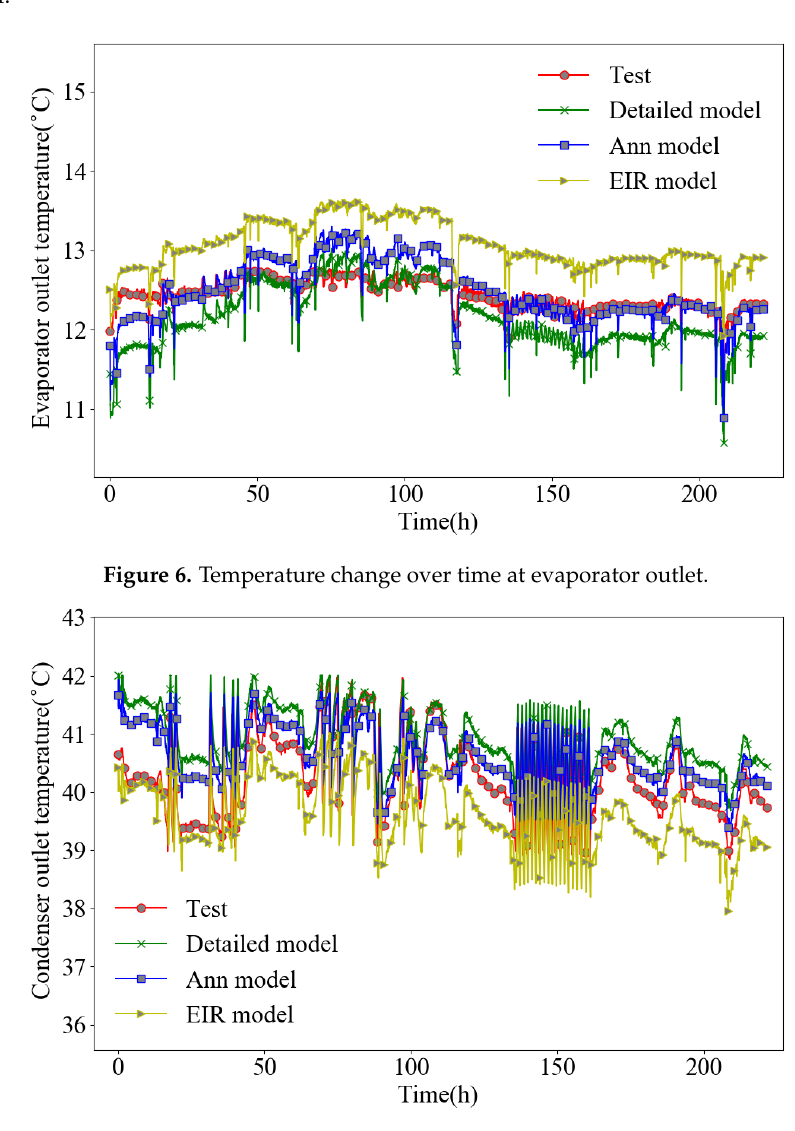
Figure 7. Temperature change over time at condenser